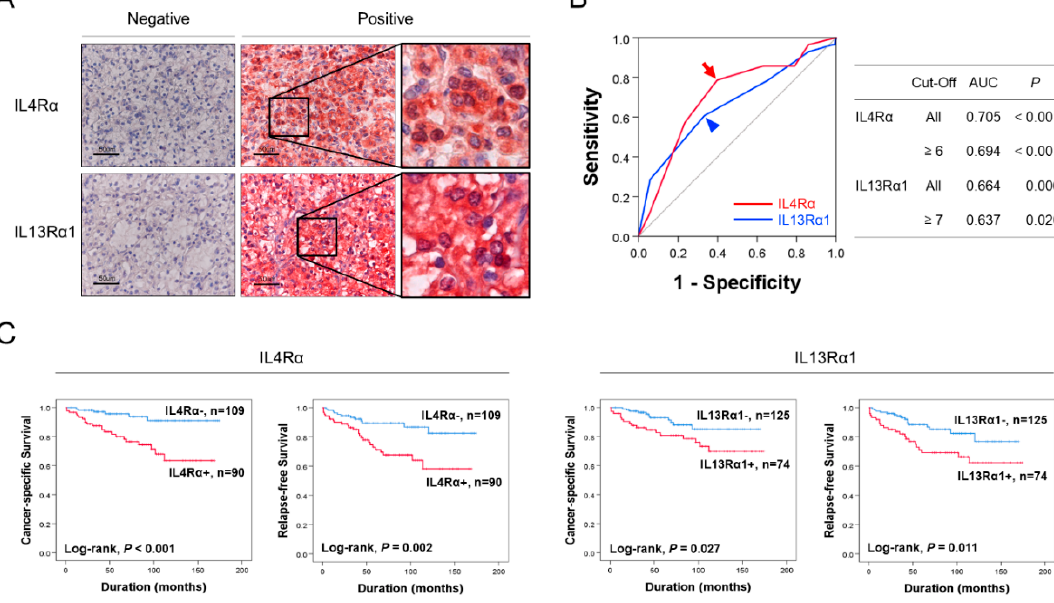
Figure 1. Immunohistochemical expression and survival analysis for the expression of interleukin4 receptor α (IL4R α ) and interleukin13 receptor α 1 (IL13R α 1) in clear cell renal cell carcinoma (CCRCC). ( A ) Immunohistochemical expression of IL4R α and IL13R α 1 in CCRCC tissue. Original magnification, ×400. ( B ) Analysis of sensitivity and specificity of the immunohistochemical staining score of IL4R α and IL13R α 1 in CCRCC for the event of cancer-specific survival (death of the patient by CCRCC) by receiver operator characteristic curves. The cutoff points were determined at the highest area under the curve (AUC). Red arrow indicates a cutoff point for the IL4R α immunostaining and blue arrowhead indicates a cut-off point for the IL13R α 1 immunostaining. ( C ) Kaplan-Meier survival analysis for cancer-specific survival and relapse-free survival according to the immunohistochemical positivity for IL4R α and IL13R α 1 in 199 CCRCC. ( D ) Kaplan-Meier survival